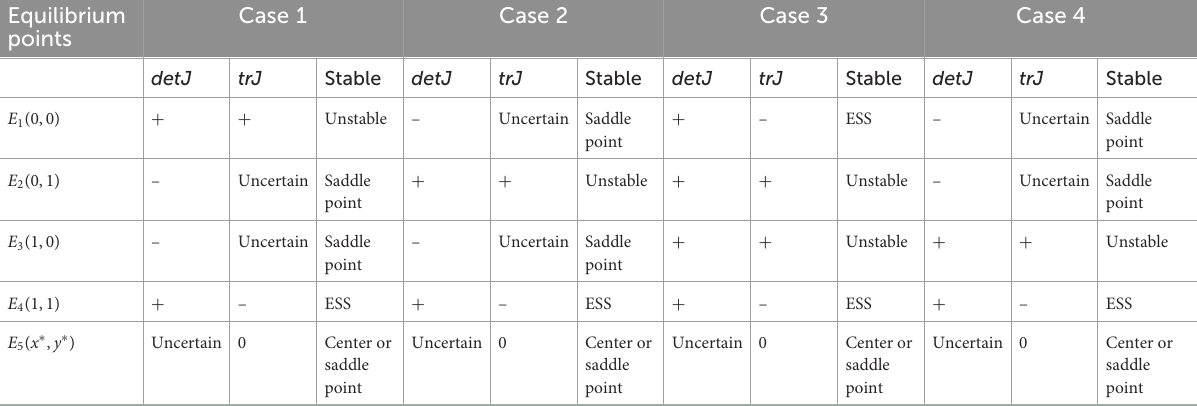
TABLE 2 Results of local stability analysis. Equilibrium Case 1 Case 2 points detJ trJ Stable detJ trJ Stable detJ trJ